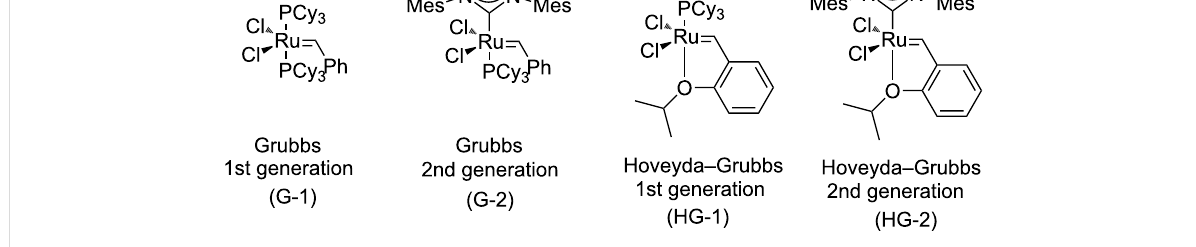
Figure 1: Commercial Ru-based catalysts used in the current work.